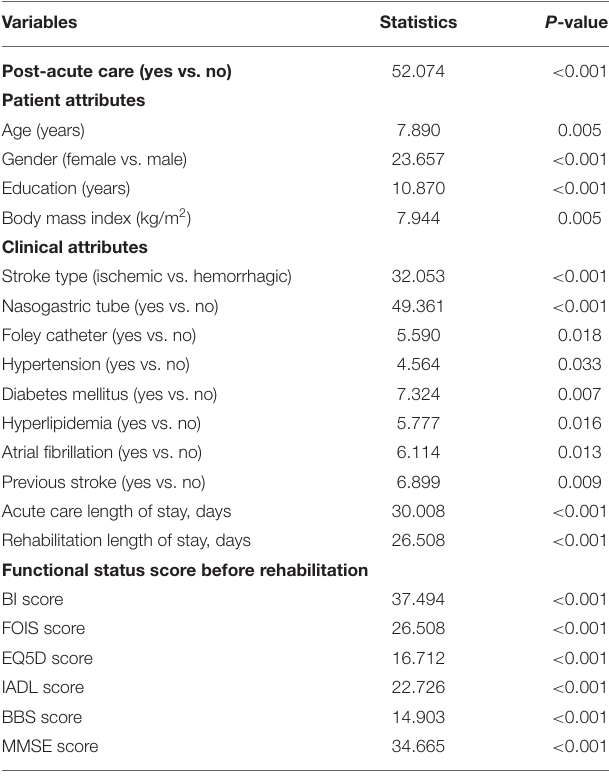
TABLE 3 | Univariate analysis of selected risk factors for 30-day readmission in patients with stroke ( N =